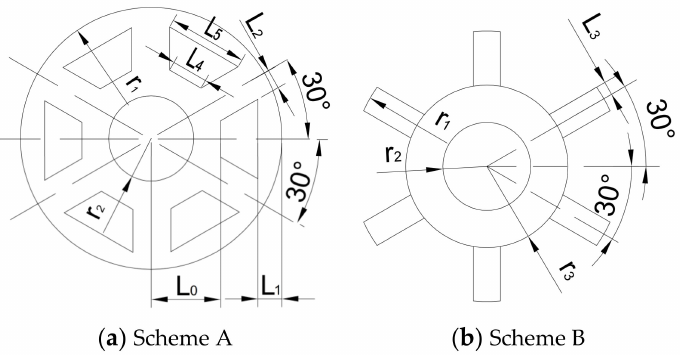
Figure 17. Slotting solutions for